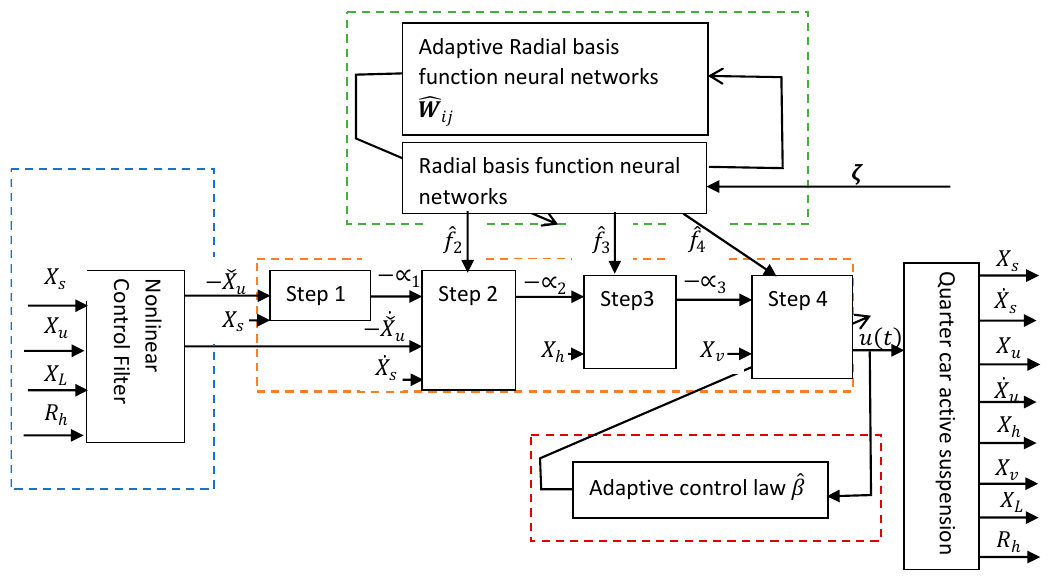
Figure 4. Sketch paths of the novel adaptive control ‘NAC ‘system.